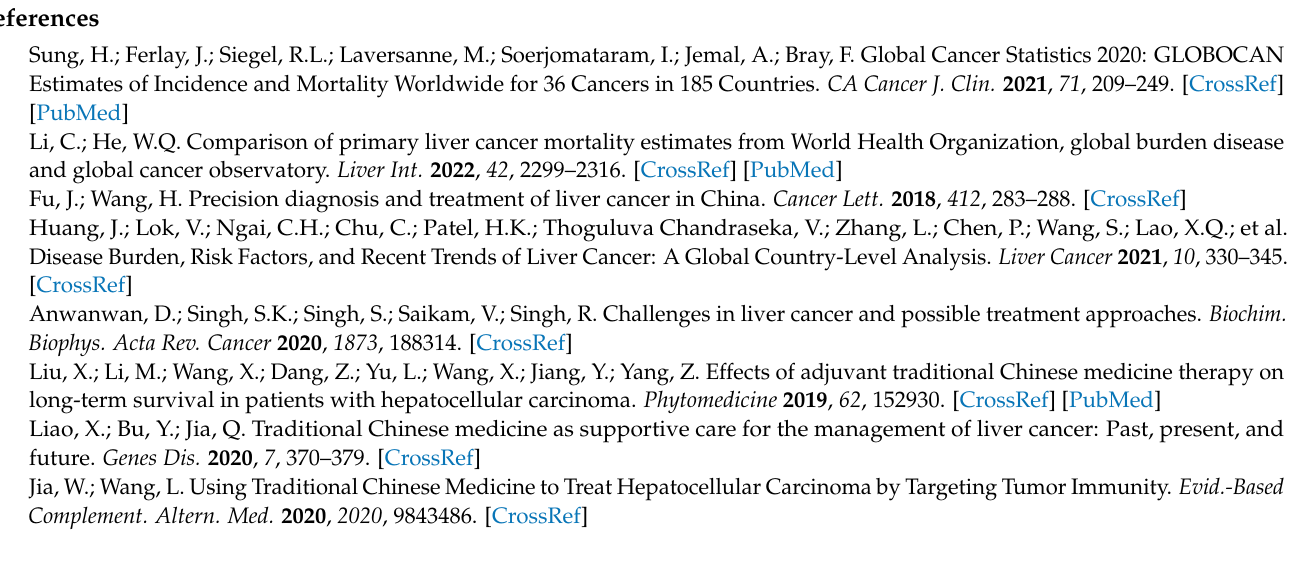
of a; Figure S2: 1 H NMR characterization result of b; Figure S3: 1 H NMR characterization result of c; Figure S4: 1 H NMR characterization result of mannose acrylamide M1; Figure S5: 1 H NMR characterization result of buf ester; Figure S6: 1 H NMR characterization result of copolymer P1. Figure S7: The sample picture of copolymer P1. Figure S8: The sample picture of polymer-buf conjugate